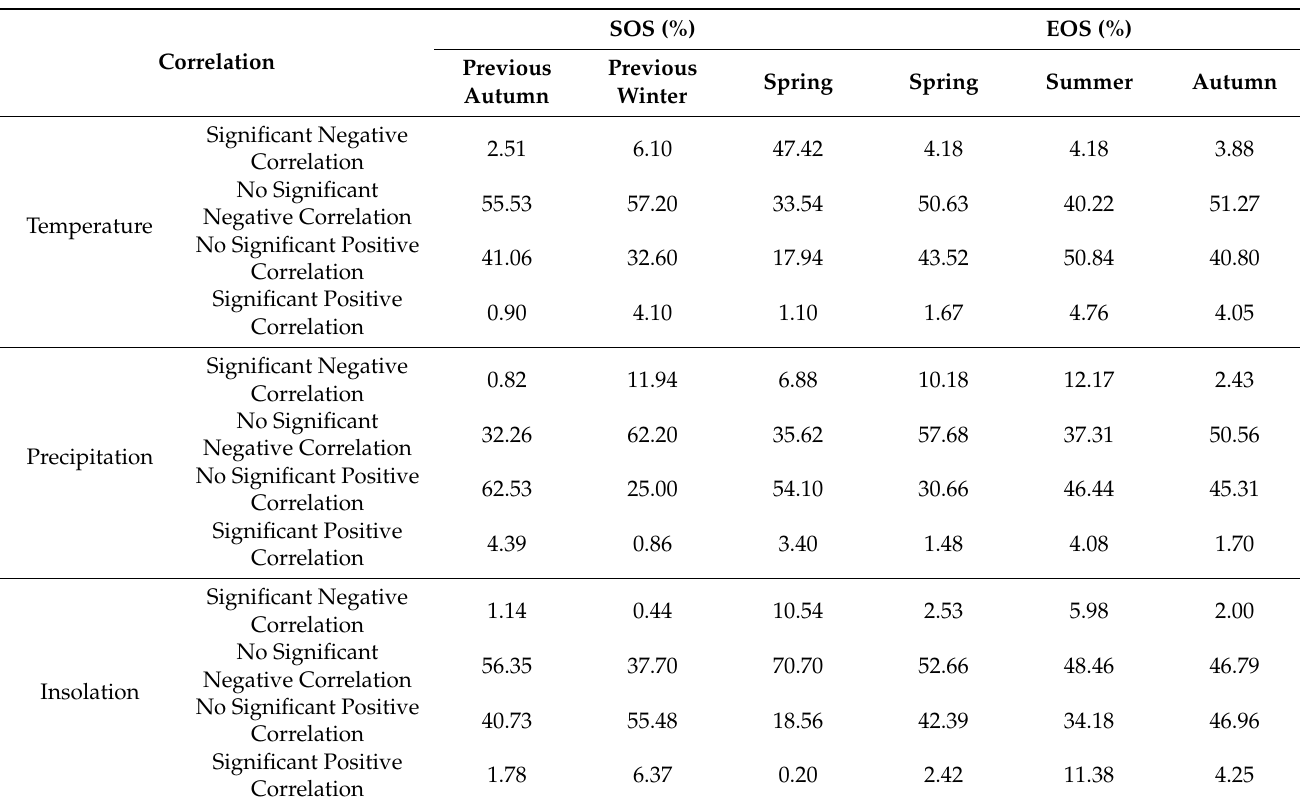
Table 3. Percentage of total study area under different types of correlation between vegetation phenological parameters and climate variables during 1982–2014 (5% significance